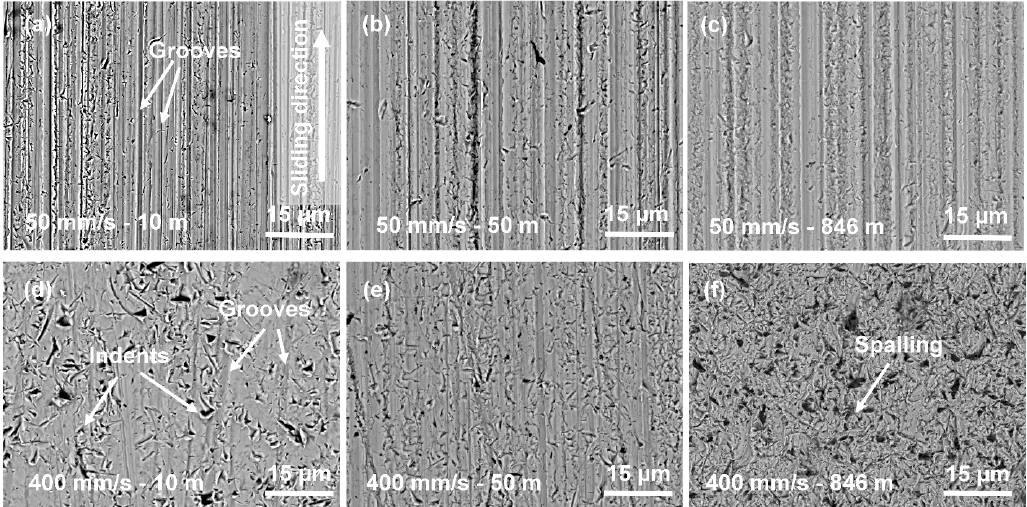
Fig. 5 SEM images of pins after constant speed experiments: (a) sliding 10 m at 50 mm/s; (b) sliding 50 m at 50 mm/s; (c) sliding 846 m at 50 mm/s; (d) sliding 10 m at 400 mm/s; (e) sliding 50 m at 400 mm/s; and (f) sliding 846 m at 400